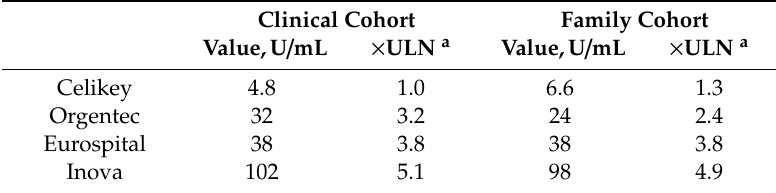
Table 3. Highest positive anti-transglutaminase 2 antibody value without celiac disease diagnosis for each study assay tested. Above these values the positive predictive value was 100% for all assays. Clinical Cohort Family